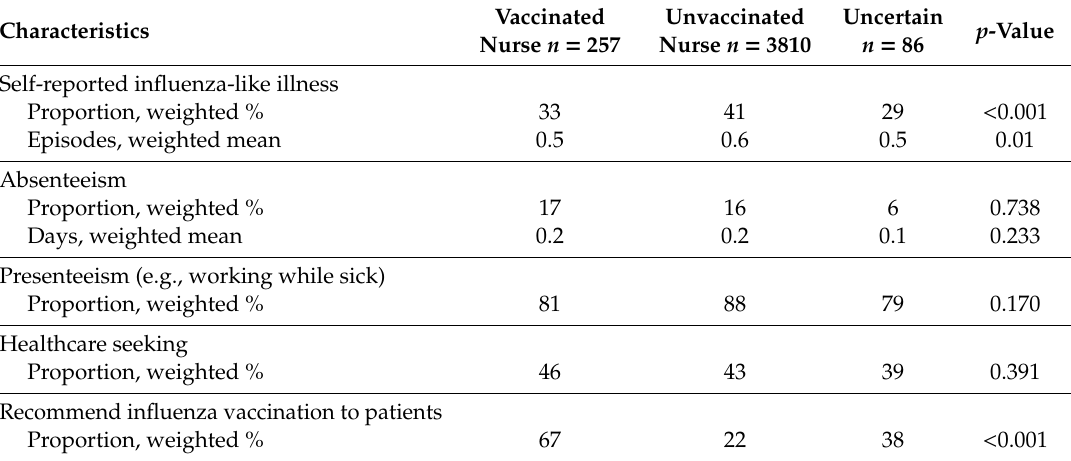
Table 3. Association between receipt of influenza vaccination and self-reported influenza-like illness, absenteeism, presenteeism, and healthcare seeking among registered nurses, China, 2017 /